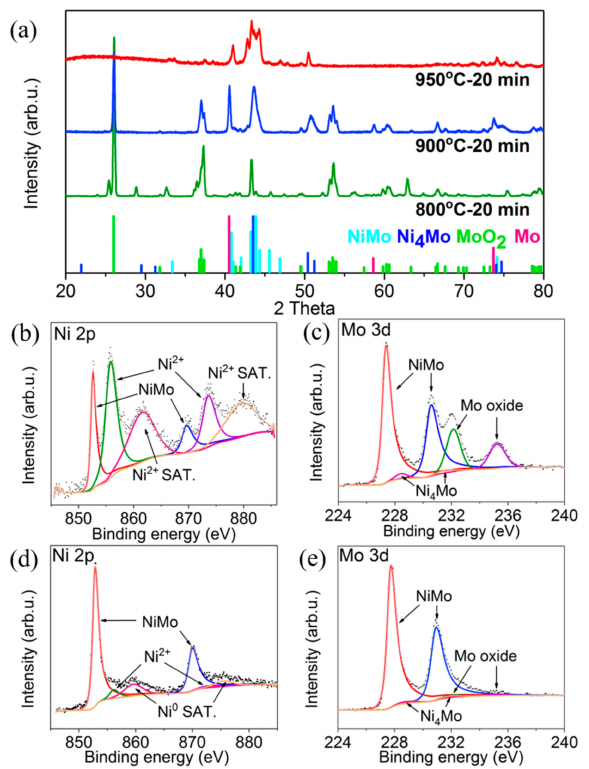
Figure 3. ( a ) XRD patterns of samples annealed at 800, 900 and 950 ◦ C. High-resolution XPS spectra of nickel 2p and molybdenum 3d spectra on porous NiMo samples annealed at ( b , c ) 900 ◦ C for 20 min and ( d , e ) 950 ◦ C for 20